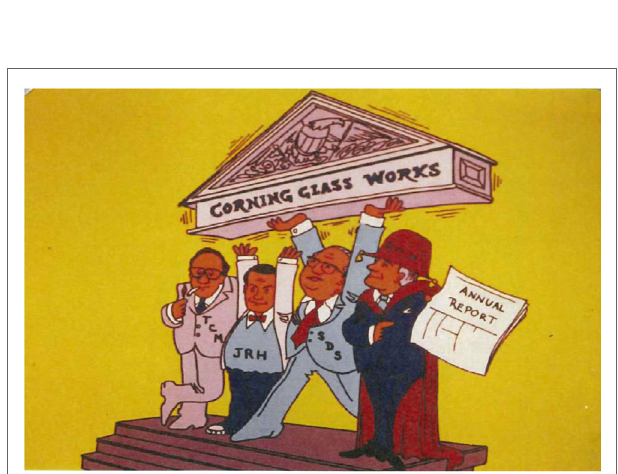
FiGURe 14 | Cartoon given to Don Stookey by Corning Senior Management